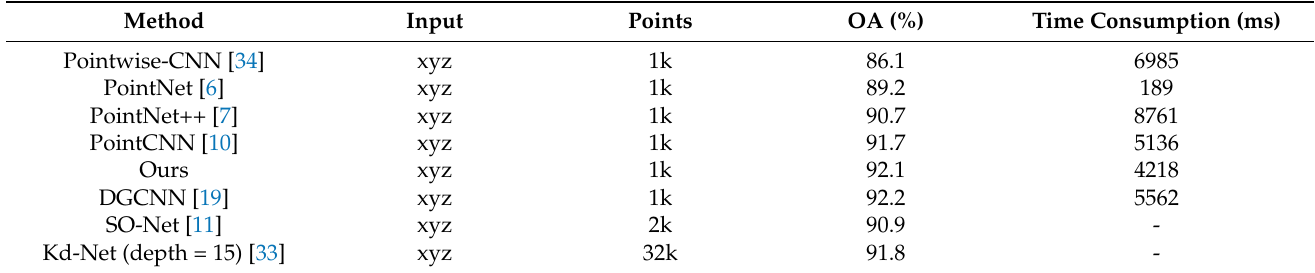
Table 1. Shape classification results (%) based on the ModelNet40 benchmark.